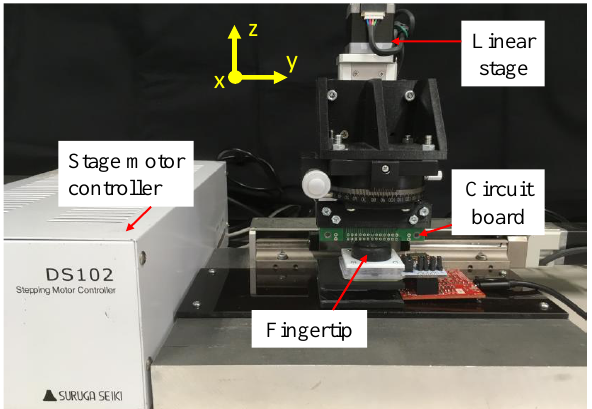
Figure 2. Experimental setup for pushing test with various soft fingertip designs.